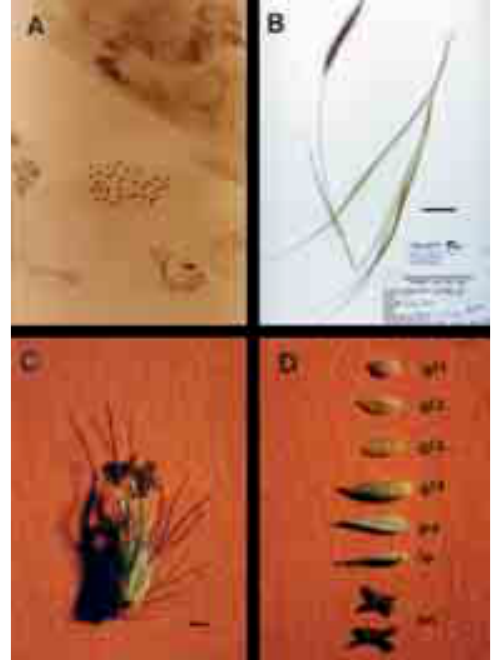
Figure 4 - Wild BAG 3 ( P. setosum ). A. Mitotic metaphase with 2n = 54 chromosomes; B. Specimens; C. Spikelet; D. Constituent of the spikelet: an (anthers), le (lemma), pa (palea), gl2 (2 nd glume), gl1 (1 st glume). The bars represent: A. 5 µ m; B. 5.6 cm; C and D. 2.3 mm. UFLA. Lavras, MG, Brazil, 1998.